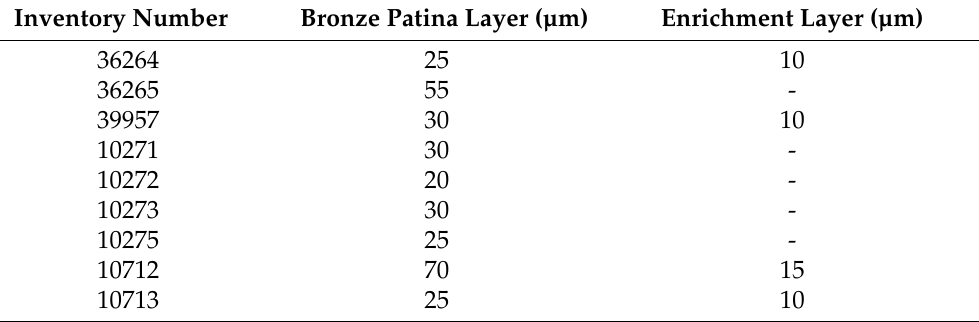
Table 3. Oxidation layer structure